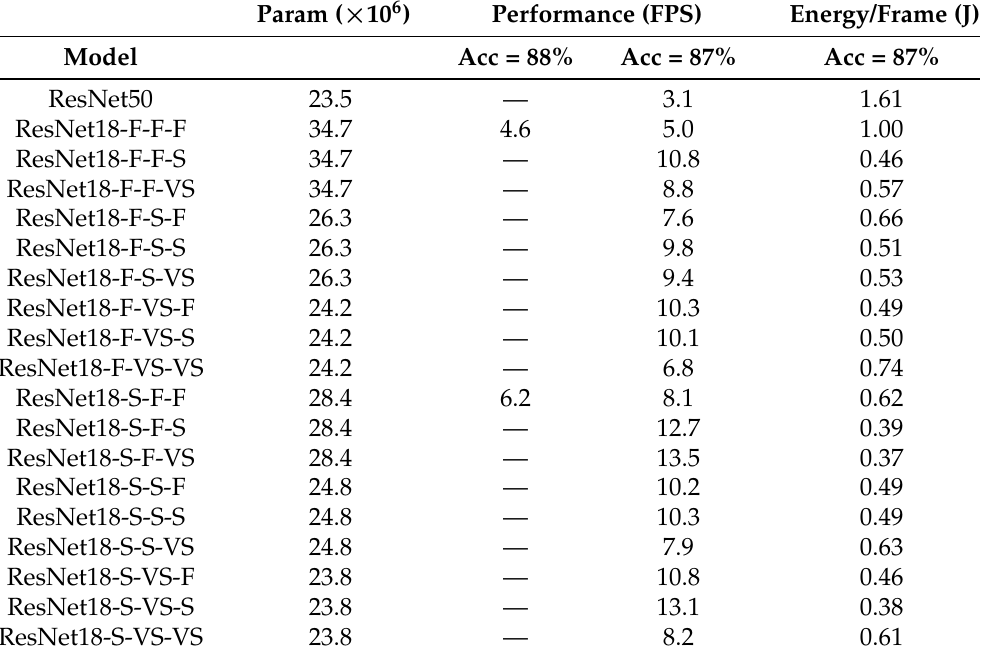
Table 5. Accuracy and performance of dual models running in the